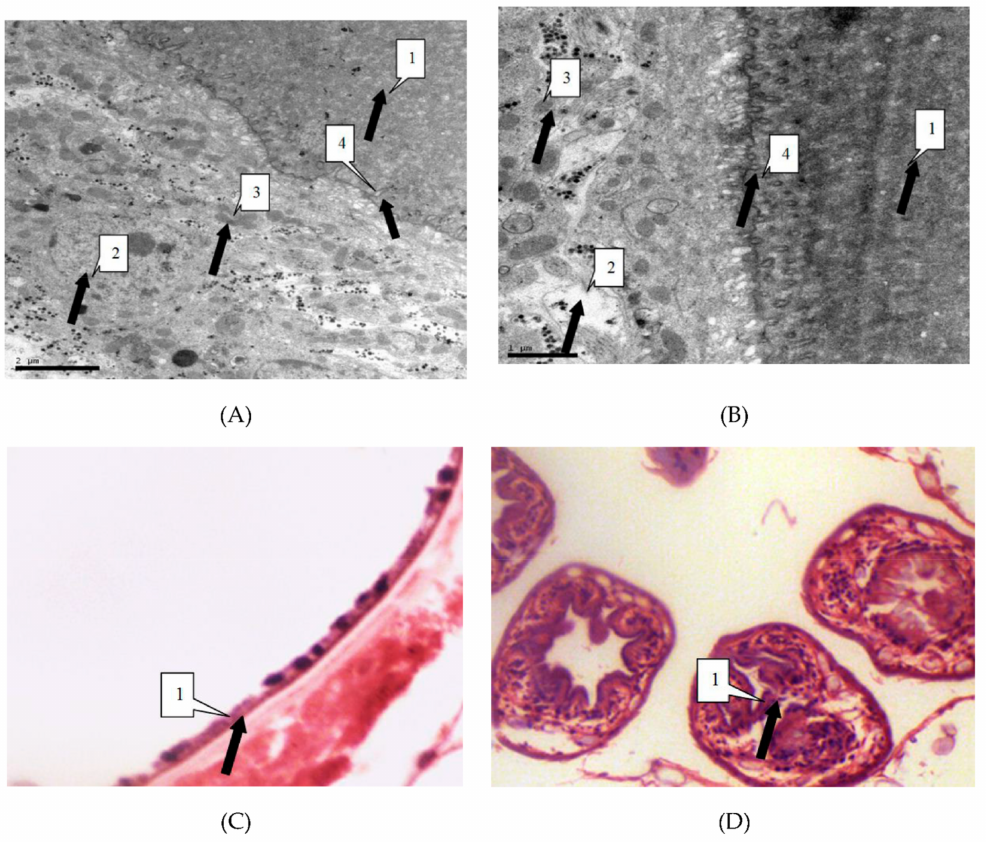
Figure 3. ( A ) Electron microscope magnified 10,000 times. As shown by the arrow, cells of the germinal layer (2) down (3) into the laminated layer (1). Organelles such as cells of the germinal layer (4) mitochondria and Golgi complex show basic integrity. No devoid of villi. ( B ) Electron microscope magnified 20,000 times. The Figure B describes similar changes to the Figure A. ( C ) The light microscope magnified 400 times. As shown by the arrow, the germinal layer (1) and laminated layer (1) remained intact. ( D ) The light microscope magnified 1,000 times. As shown by the arrow, the form of protoscoleces remained